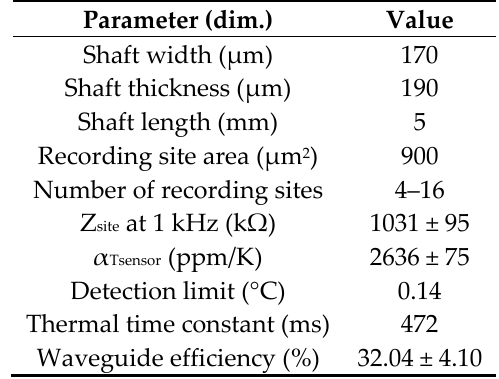
Table 1. A summary of the microelectrode’s characteristic